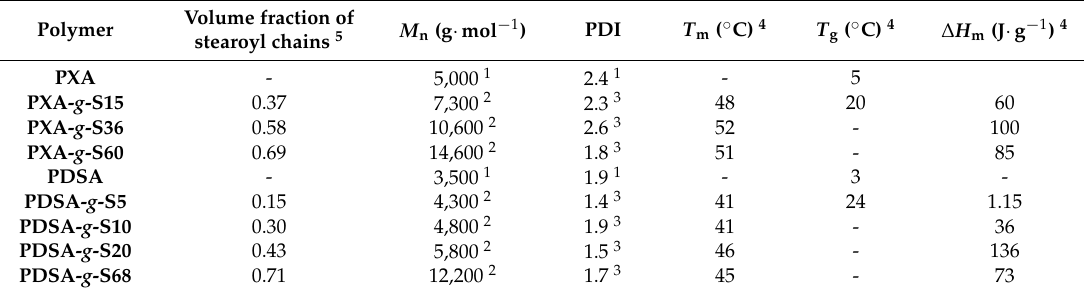
Table 1. Volume % of side chains, M n , polydispersity index (PDI), glass transition temperature ( T g ) melting temperature ( T m ) and melting enthalpy ( ∆ H m ) of